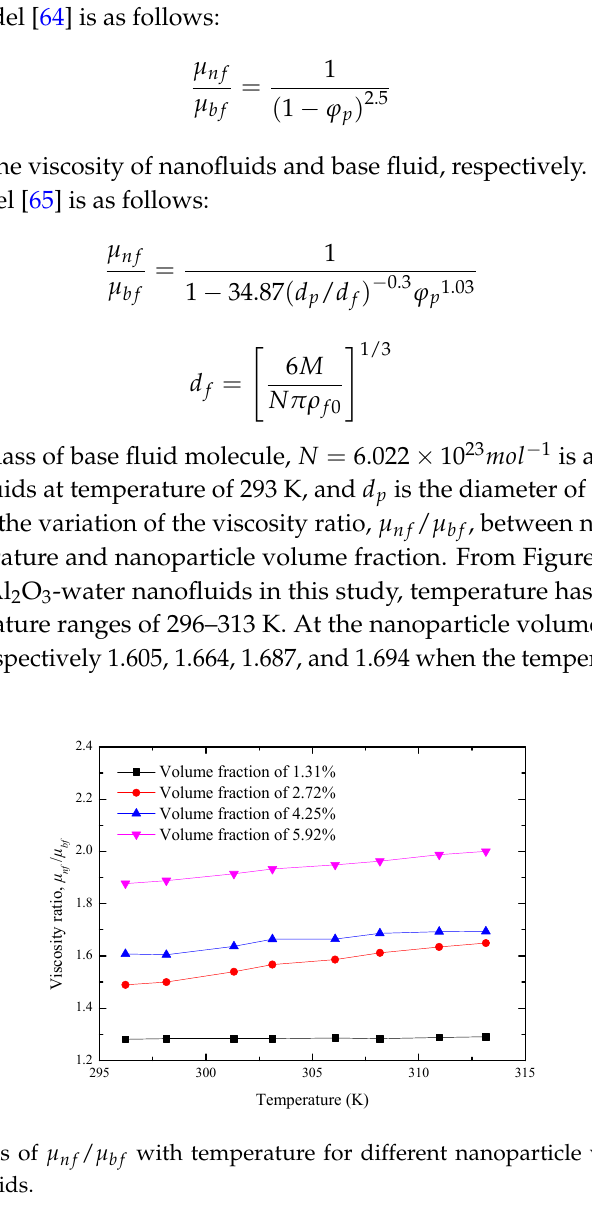
Spread=0.1 Spread=0.3 Spread=0.5 Spread=0.7 Spread=1 l og 10 ( M S E ) Number of hidden layer neurons Target value Figure 13. Relationships of mean square error (MSE) and the number of hidden layer neurons with different values of Spread.